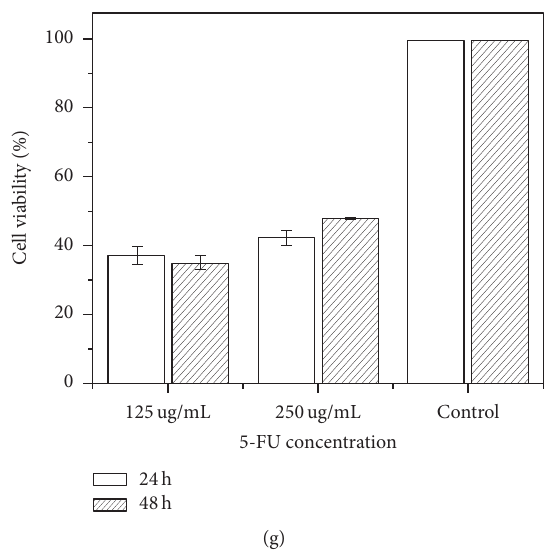
Figure 5: Viability results of the test made using the MTT assay on fibroblast cells (HGF-1). Control is (HGF-1) without sample. (a) Sample HAP; (b) sample HAPEu3%; (c) sample HAPEu5%; (d) sample HAPEu10%; (e) sample HAPEu20%. (f) Results of the viability tests made using the MTT assay on HeLa cells with sample HAPEu5%+5FU. Control is HeLa cells without HAP sample. (g) Results of viability tests using the MTT assay 5-fluorouracil (5-FU) against HeLa cells.